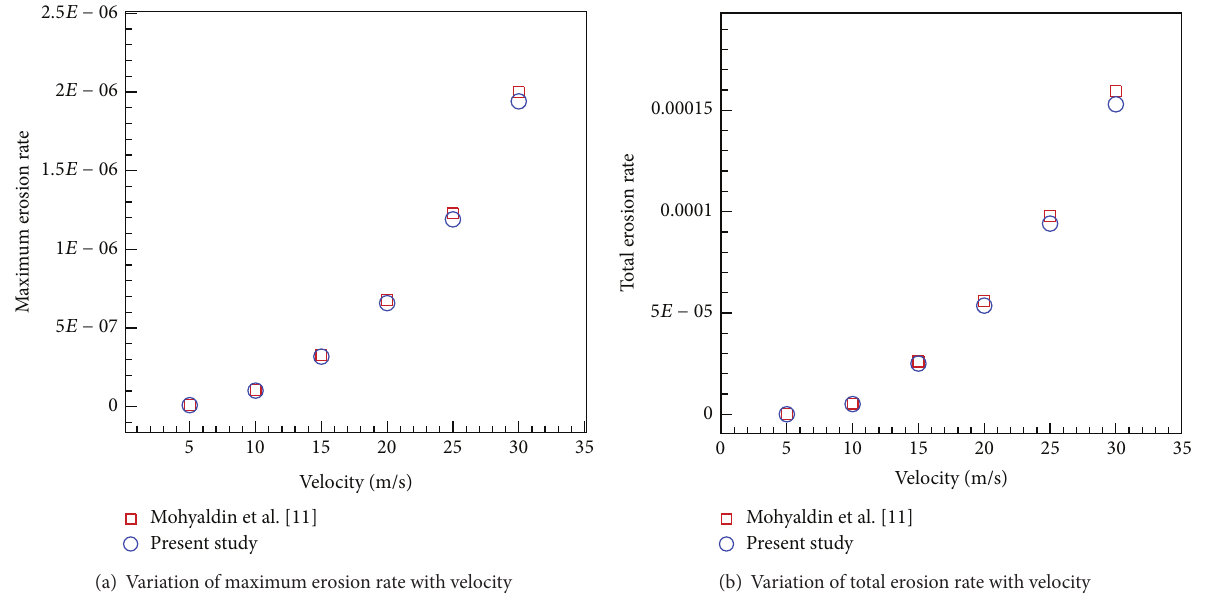
Figure 2: Comparison of total erosion rate and maximum erosion rate predicted here with those of [11].